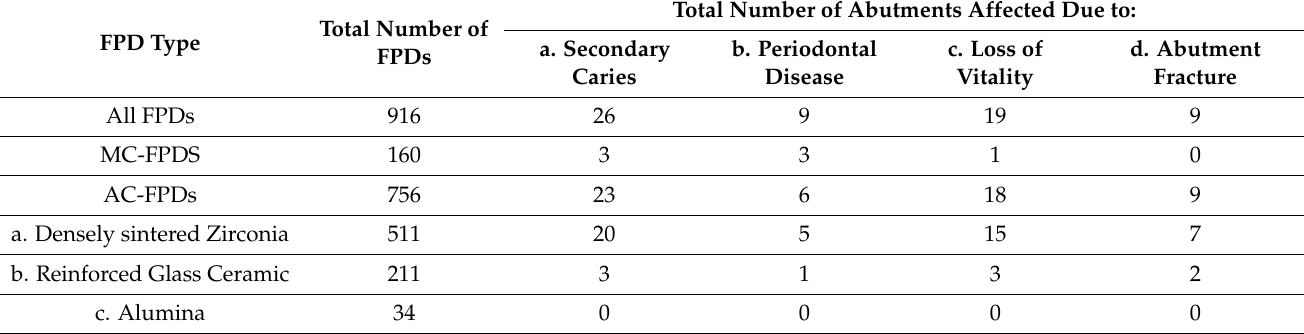
Table 3. Biological complications of metal-ceramic and all-ceramic fixed partial dentures.